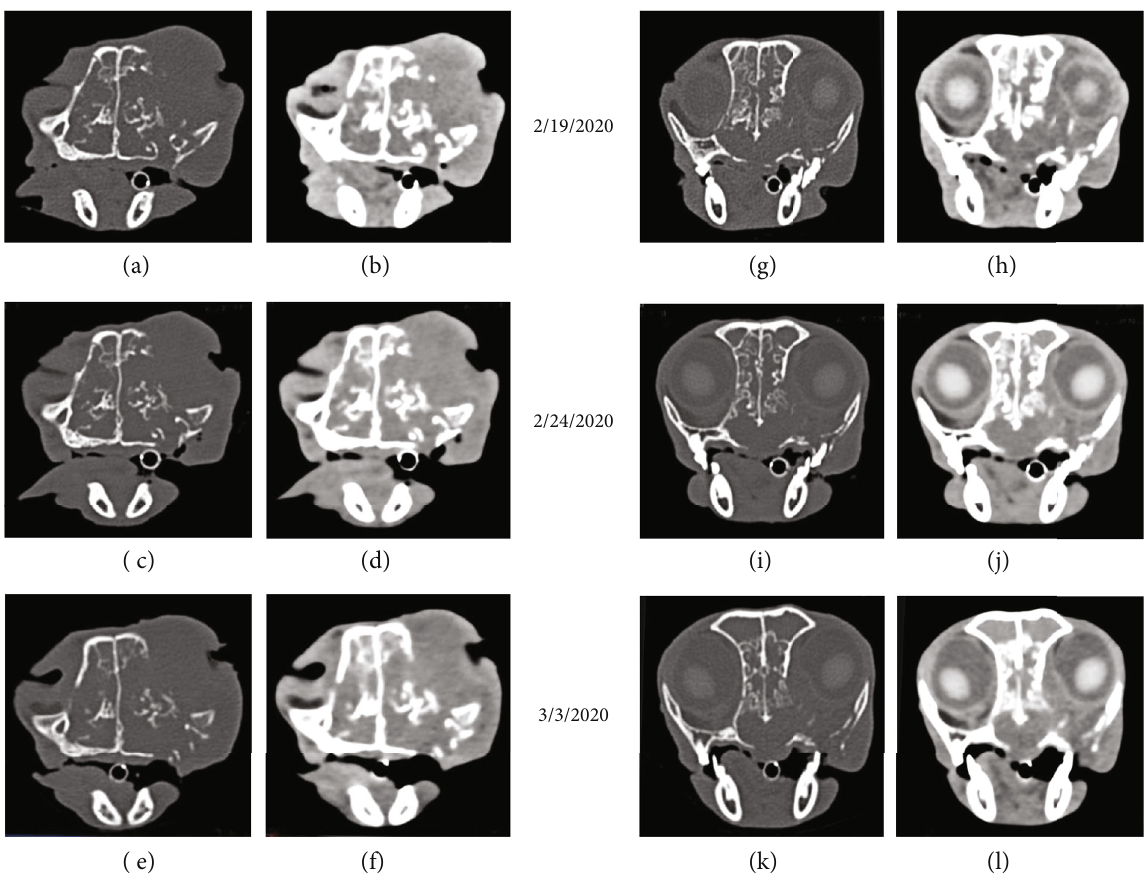
Figure 4: The CT images depict soft tissue and bone window images of closely comparable rostral (a-f) and caudal (g-l) portions of the tumor shown before (a, b, g, h) and after (c, d, i, j, e, f, k l) each of 2 rounds of treatment with TOL. Despite the improvement in the patient ’ s level of social interaction and appetite, there was no evidence to support a reduction in the tumor